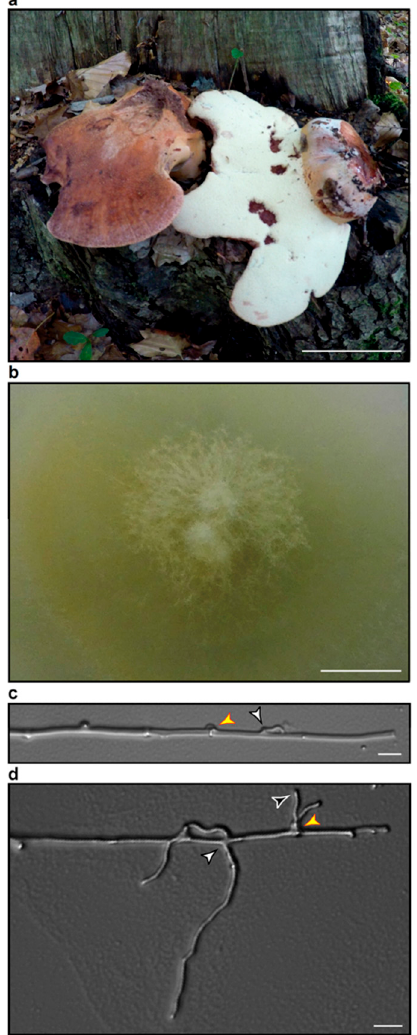
Figure 2. Basidiome and mycelial morphology of the F. hepatica wild strain employed in the present study. The shown mycelial culture served to generate basidiomycete ethyl acetate crude extract BE05. ( a ) Pileal surface (left specimen) as well as stipe and pore surface (right specimen) of two fruiting bodies growing from a stump of an oak tree in a mixed Fagus sylvatica forest. The scale bar represents 5 cm. ( b ) Mycelial colony morphology of F. hepatica growing on potato dextrose agar (PDA) at 25 ◦ C. The scale bar represents 1 cm. ( c , d ) Typical hyphal morphology of F. hepatica, indicating a clamp connection (red-framed yellow arrowhead) at a septum between two dikaryotic hyphal segments of aerial mycelium at the colony margin. Such clamp connections may grow out to form new hyphae (d, white-framed black arrowhead). Side-branch formation on F. hepatica hyphae normally occurs via outgrowth of side branches at acute angles (c-d, black-framed white arrowheads). Such a side branch is either more or less equally sized to the hypha from which it grows out (d, black-framed white arrowhead) or it branches o ff as a very narrow hypha (c, black-framed white arrowhead) from a wide hypha. The scale bar represents 10 µ